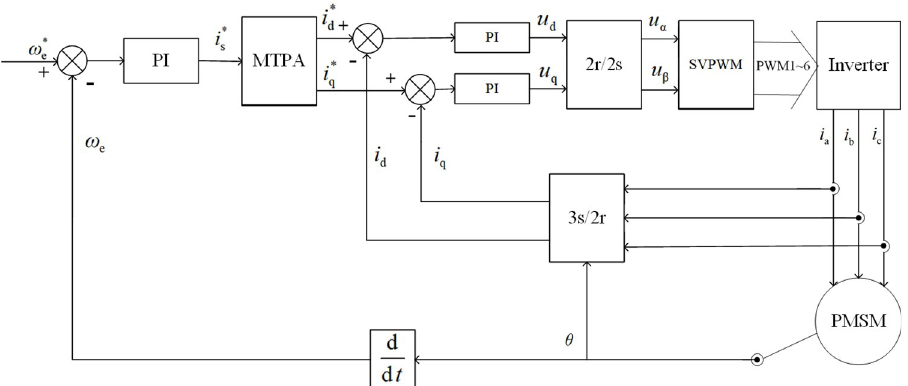
Fig 1. Block diagram of the traditional MTPA control